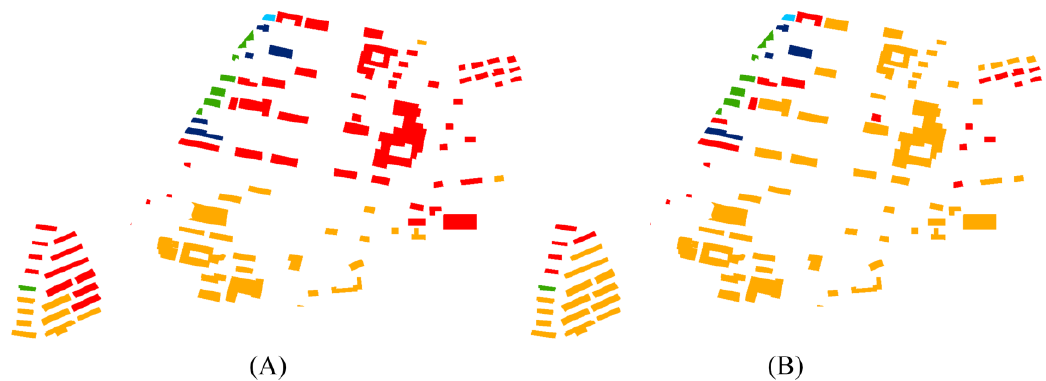
Figure 7. Figure 3 (A) #1 Analysis of the regional building function identification results ( A ) based on the spatiotemporal interaction characteristics and ( B ) based on the combination of the spatiotemporal interaction and building vitality characteristics.